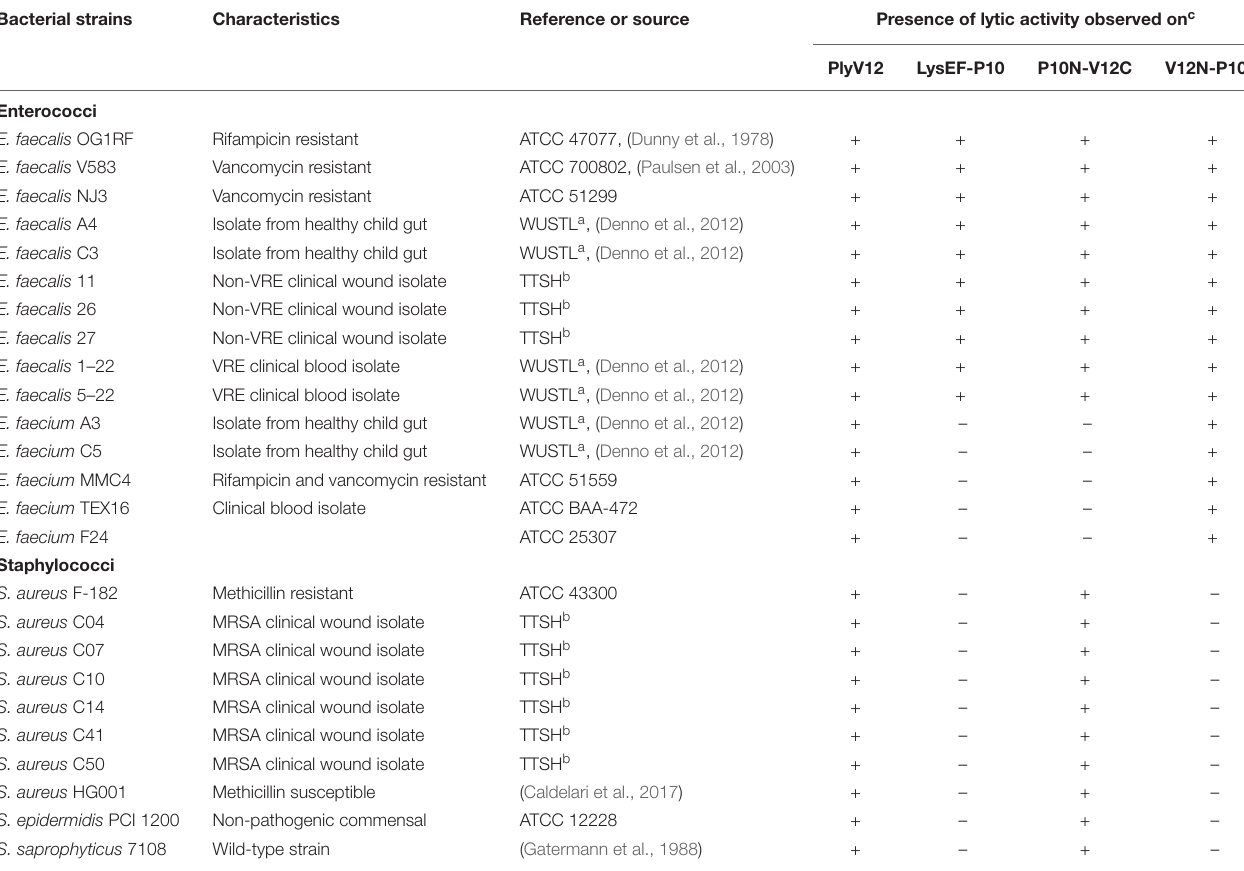
TABLE 1 | Bacterial strains used in this study and their susceptibility to the 4 lysins tested. Bacterial